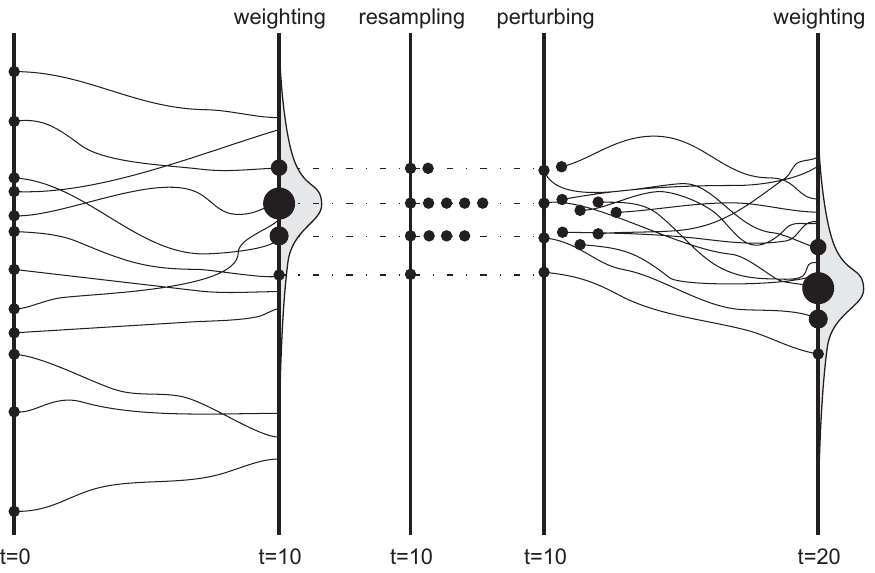
Figure 2. The importance resampling particle filter with 12 particles (modified according to van Leeuwen [86]). The model variable runs along the vertical axis, the weight of each particle corresponds to the size of the circles on this axis. t = 0, t = 10 and t = 20 denotes time, with observations at a time interval of 10 time units. All particles have equal weight at time zero. At time 10, the particles are weighted according to likelihood and resampled to obtain an equal-weight ensemble. Some studies perform a perturbation of states and/or parameters after resampling in order to avoid sample